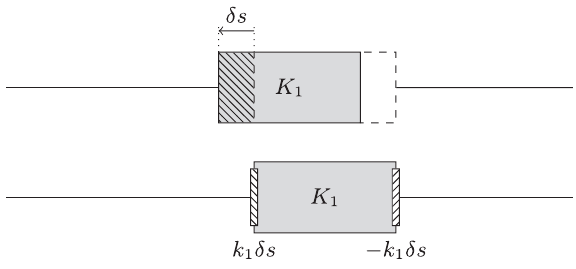
FIG. 3. The top sketch shows the displaced quadrupole (solid gray) relative to the original position (dashed). In the bottom sketch one can see the quadrupole at its original position with thin magnets on both